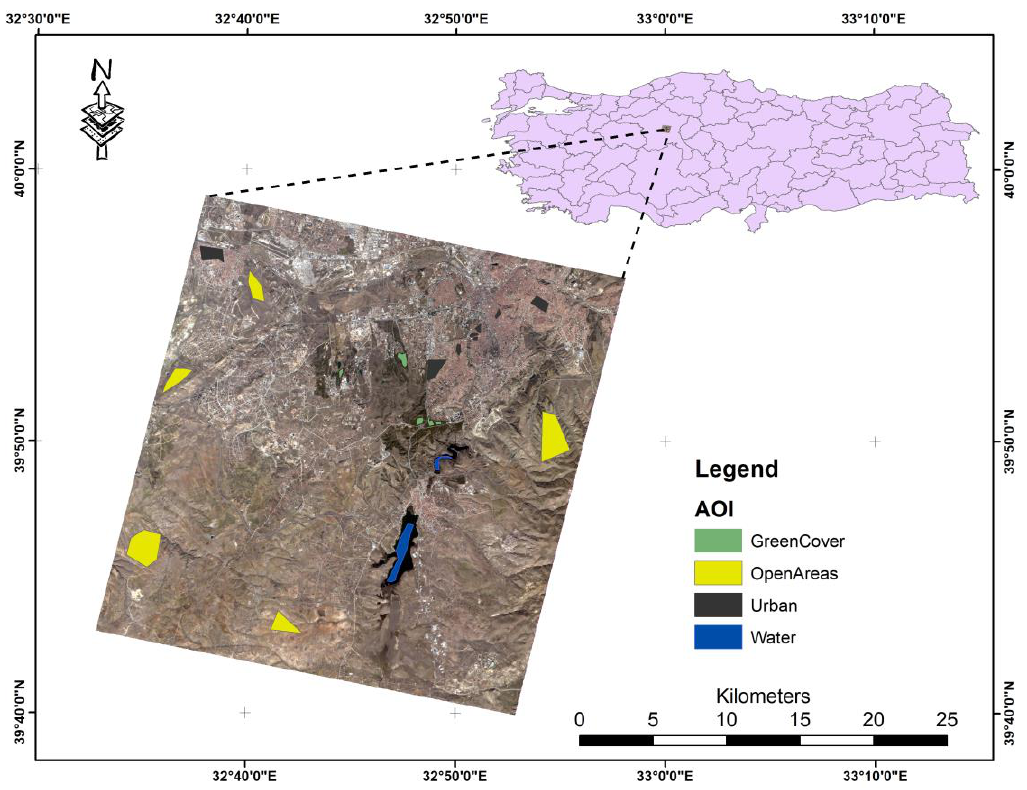
Figure 5 RASAT satellite image within Ankara